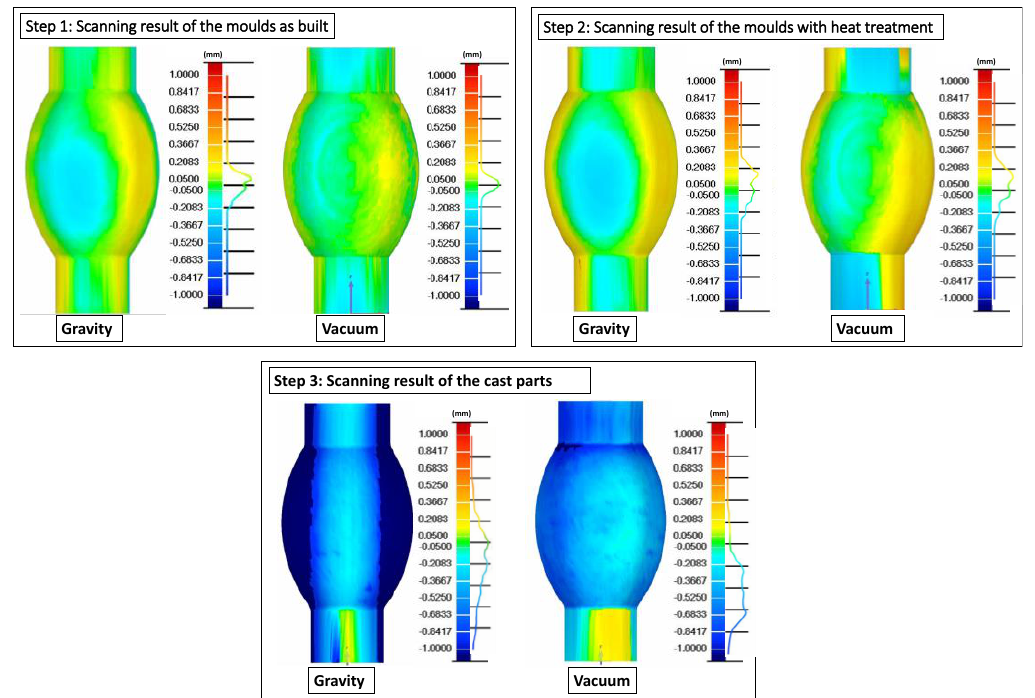
Figure 11. Scanning the three steps of the casting process for both techniques.